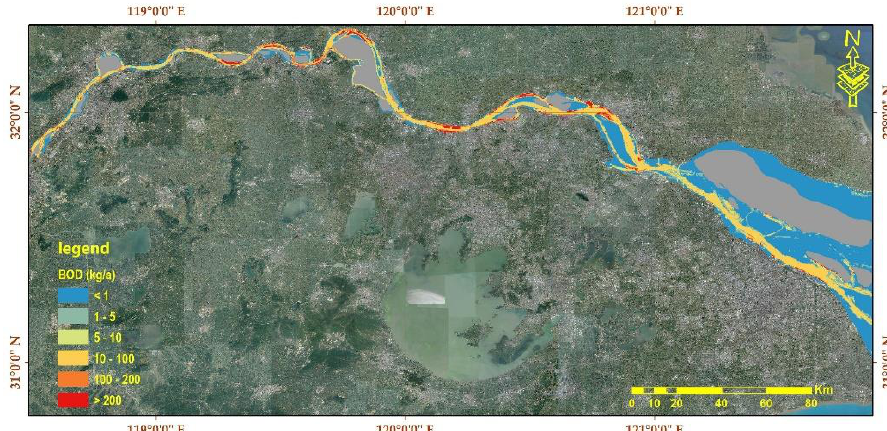
Figure 8. COD generations distribution.